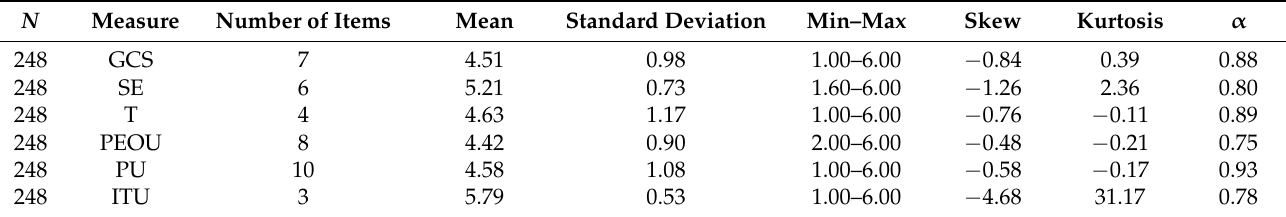
Table 3. Descriptive statistics on survey